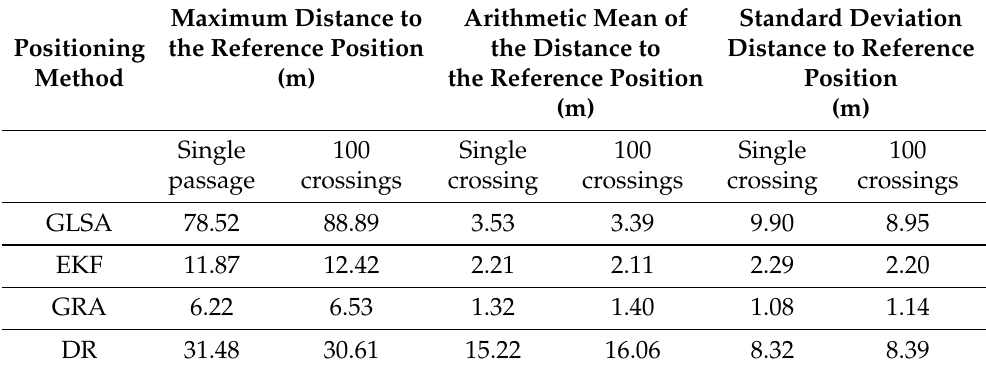
Table 2. Statistical parameters of the scatter of the distance to the reference position from the positions estimated by the GLSA, EKF, GRA, and DR